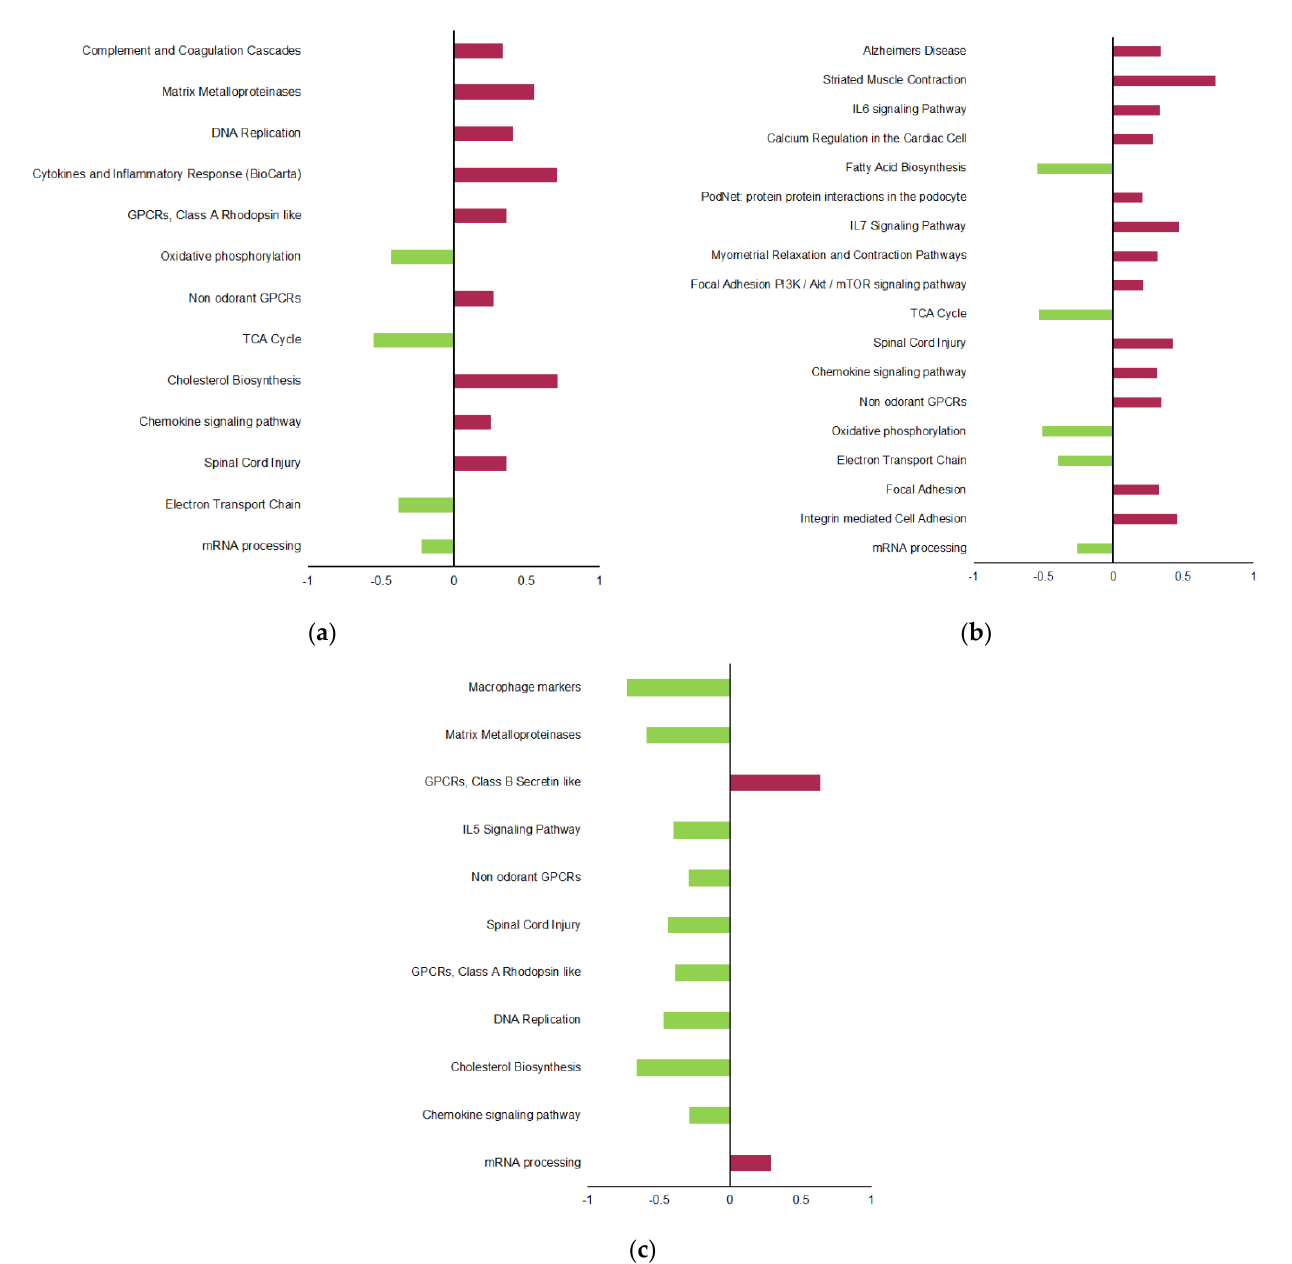
Figure 3. Regulation of pathways in VAT according to Gene Set Enrichment Analysis in the different pairwise comparisons and the WIKI database. Left panel illustrates significantly regulated pathways in HFoleic group compared to the Reference ( a ). Central panel illustrates significantly regulated pathways in HFepa group compared to the Reference ( b ). Right panel illustrates significantly regulated pathways in HFoleic group compared to HFepa ( c ). Red color means overrepresentation, green color means lower representation in HFoleic (compared to Ref in ( a ), compared to HFoleic in ( c )) or HFepa (compared to Ref in ( b )). HFoleic, mice from oleic/control lineage fed with the obesogenic diet; HFepa, mice from EPA/omega 3 lineage fed with the obesogenic diet; Reference, mice from oleic/control lineage fed with the normocaloric